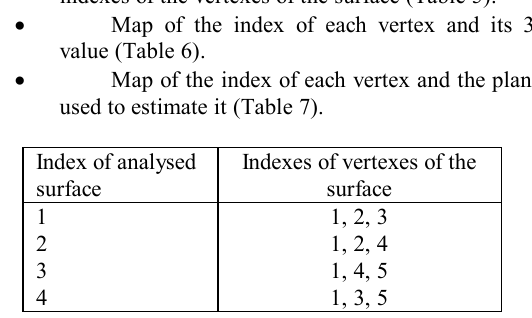
Table 5. Map of indexes of the analysed surfaces and indexes of the vertexes of the surface for Scenario 2.